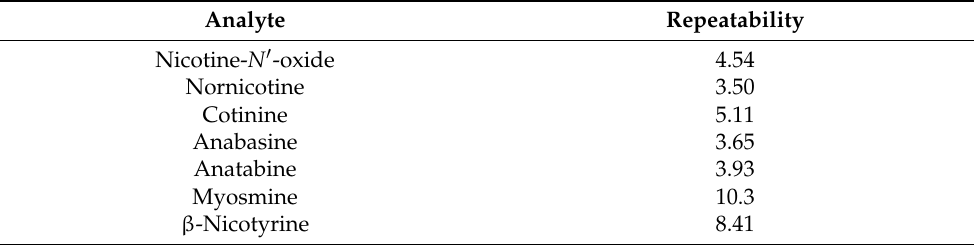
Table 4. %RSD pool for